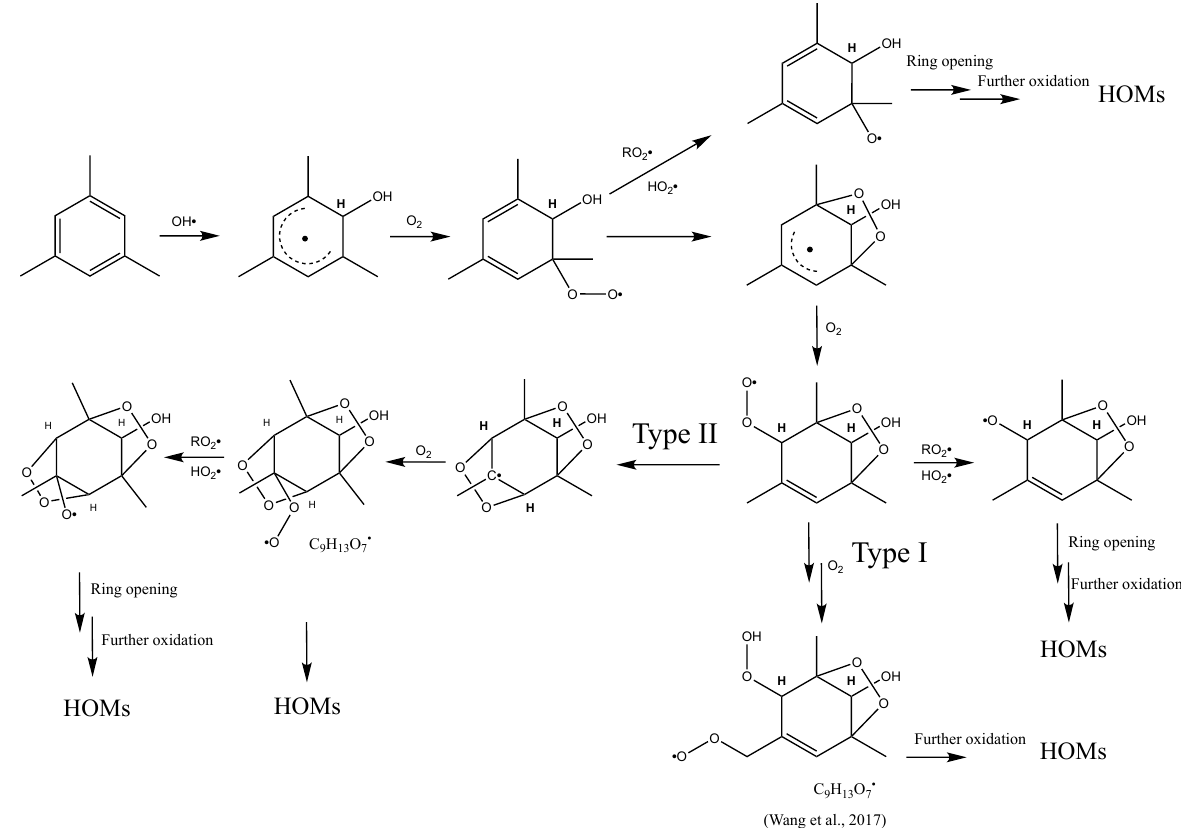
Figure 6. Proposed radical reaction mechanism for the autoxidation of mesitylene. The mechanism is derived from the MCM (version 3.3.1) up to the C 9 H 13 O 5 radical. From there the Type I pathway is from Wang et al.